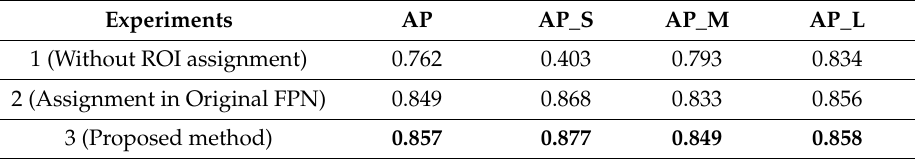
Table 4. Performance of ROI assignments in different